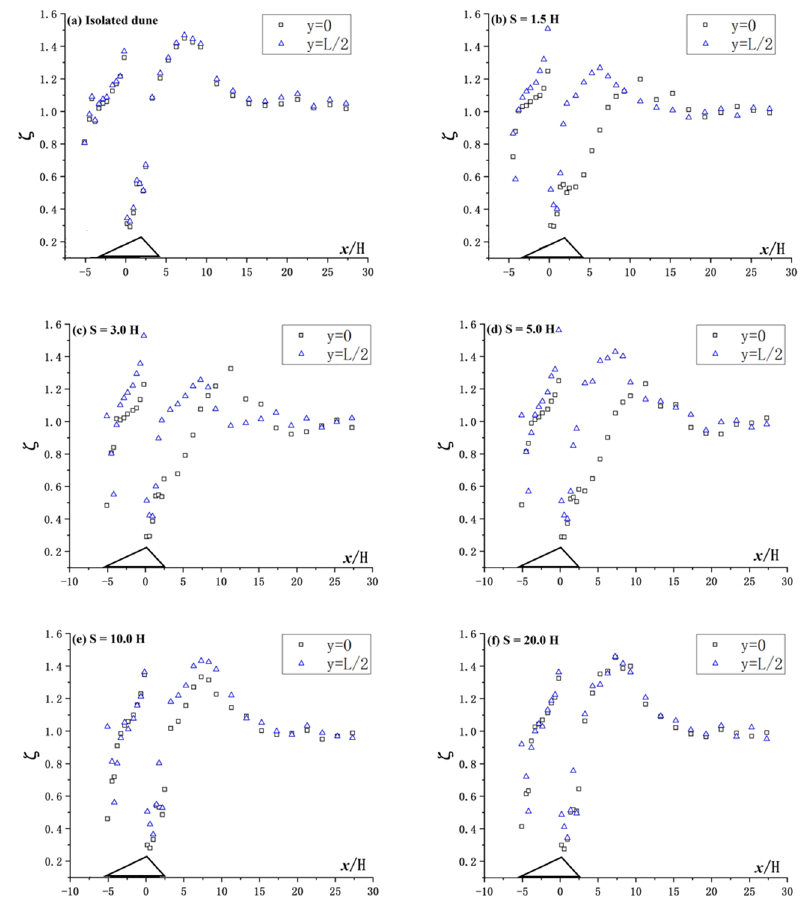
Figure 7. Normalized fluctuation of shear stress ζ with normalized distance x / H. H is the height of sand dune, L is the distance of piers of bridge, S is the distance between bridge and sand dune and y is the distance between measuring position and the y-axis.